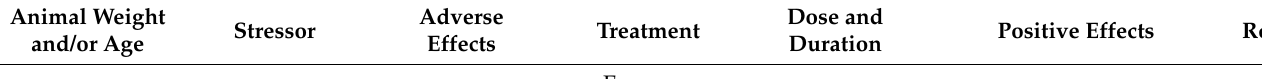
Table 2. Effects of different types of feed additives on the small intestinal health of piglets under specific